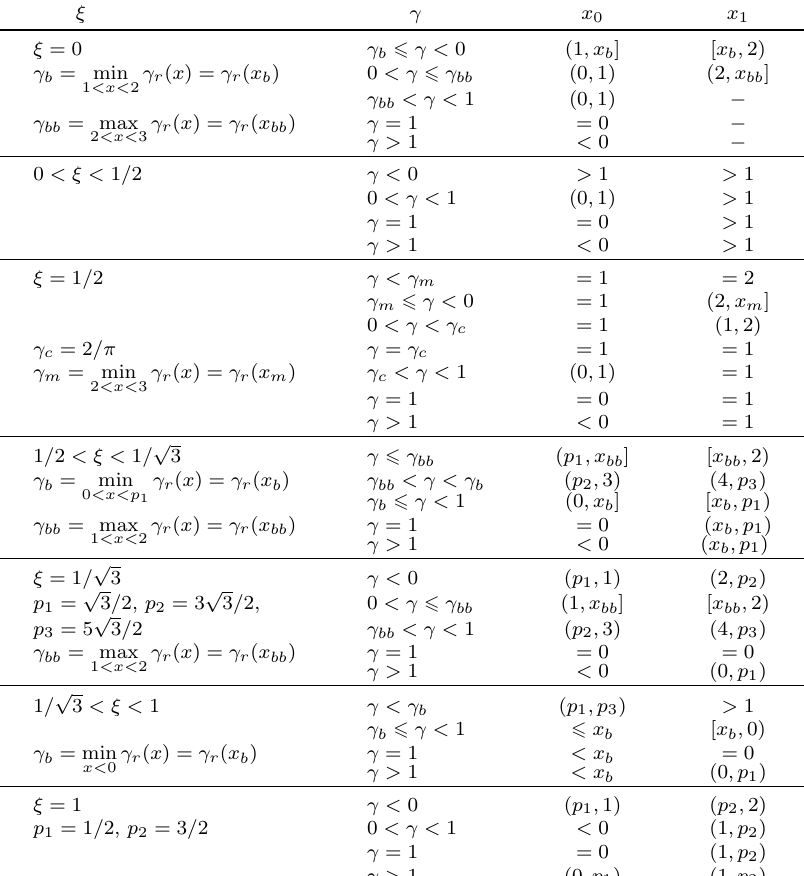
Table 1. The first two real eigenvalues λ 0 = λ r ( x 0 ) and λ 1 = λ r ( x 1 ) ( γ (cid:54) = 0). ξ γ x 0 x 1 ξ =